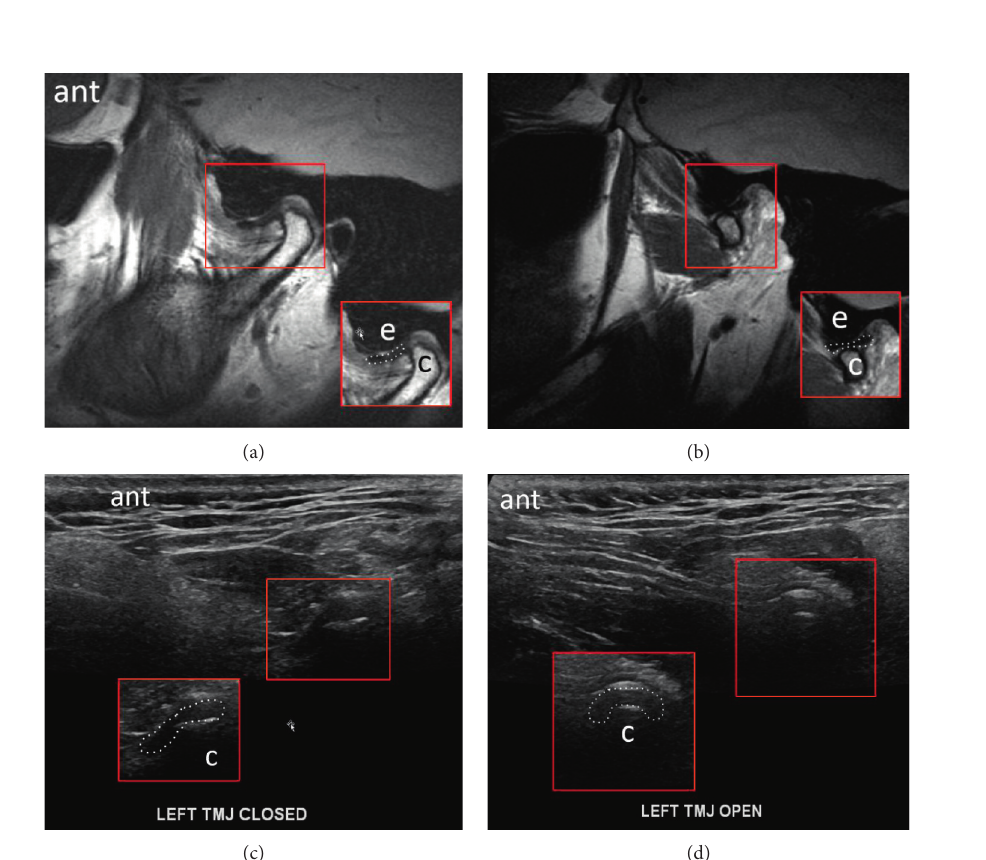
Figure 4: Images demonstrating anterior displacement of the disc in the sagittal plane in the (a) closed-mouth position with MR, (b) disc recapture in the open-mouth position with MR, (c) closed-mouth position with US, and (d) recapture in the open-mouth position with US. The disc retains normal morphology. A focal annotated view was provided to aid visualization with the articular disc outlined with a dotted contour; condyle � “c”; eminence � “e”; anterior �